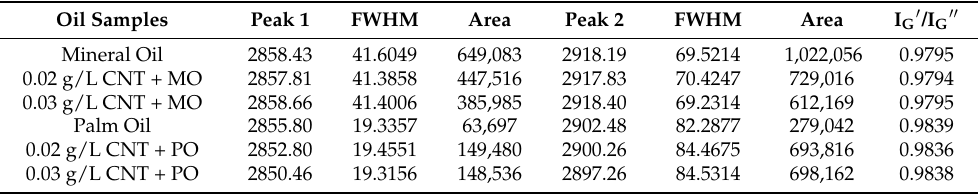
Table 1. Raman spectra information on two strong peaks at second order